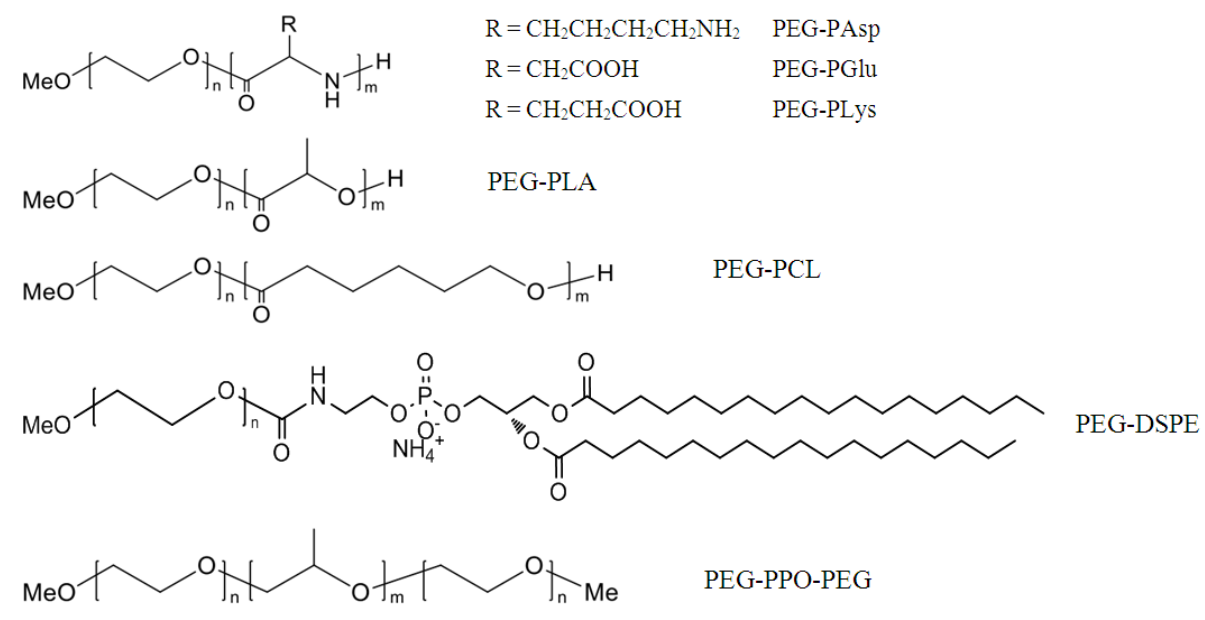
Figure 1. Chemical structures of the commonly studied block